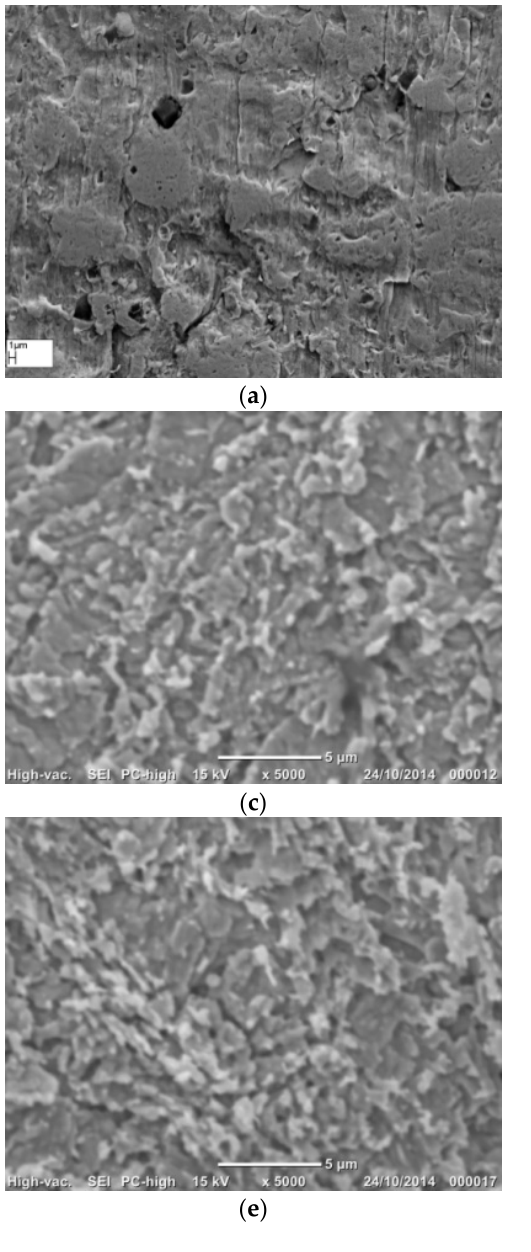
Figure 1. Effect of the different chemical etching treatments on surface morphology of Ag metal surface as seen under scanning electron microscope (SEM): ( a ) native as-flattened Ag wire; ( b ) 30 s NH 4 OH; ( c ) 10 s HNO 3 ; ( d ) 2 m HNO 3 ; ( e ) 30 s NH 4 OH followed by 10 s HNO 3 ; and ( f ) 30 s NH 4 OH followed by 2 m HNO 3 .